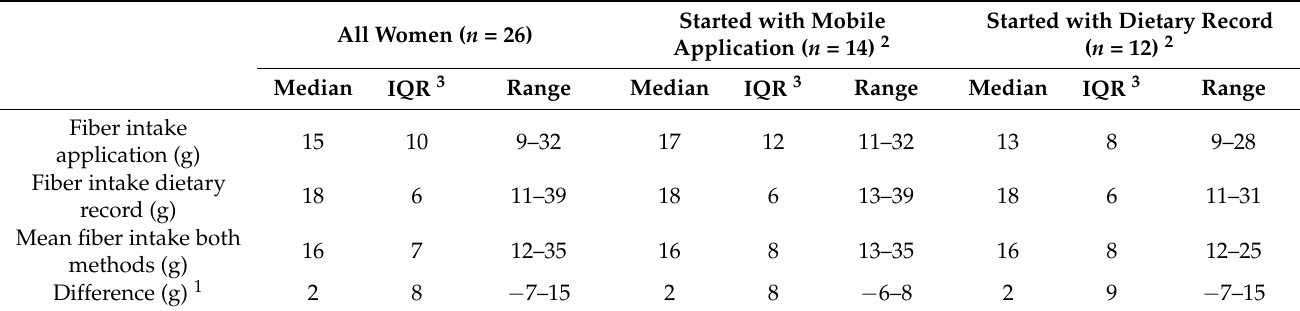
Table 2. Dietary fiber intakes and the difference between the assessment methods presented for all women and separately for the two randomized